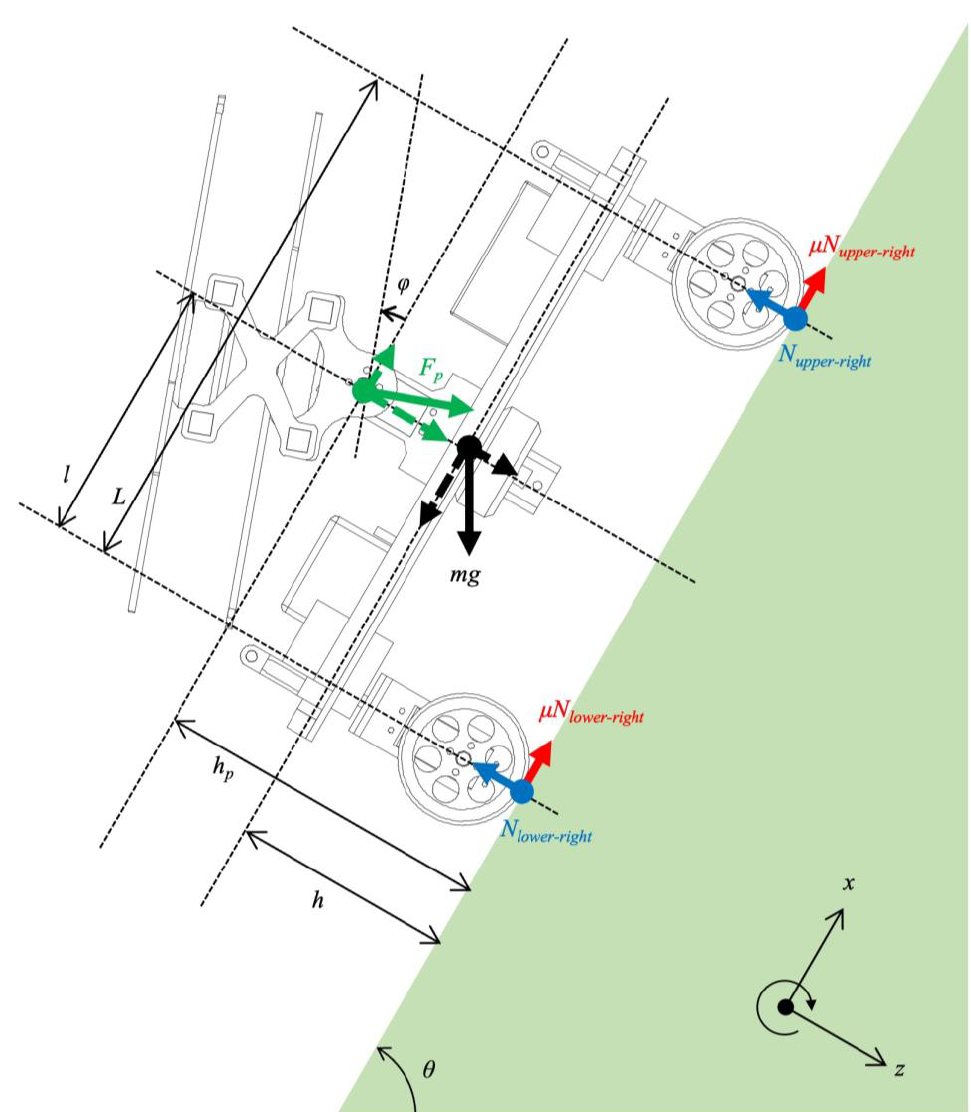
Figure 3. Force diagram of the proposed robot.